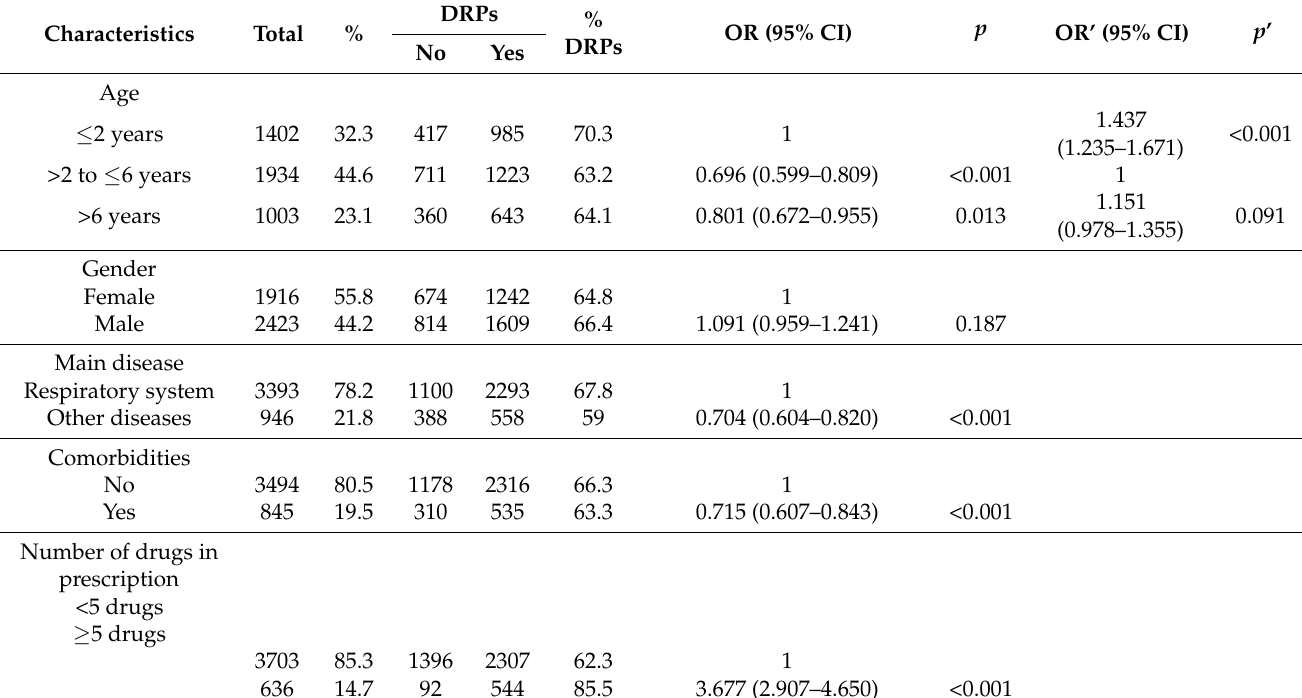
Table 6. DRP determinants in